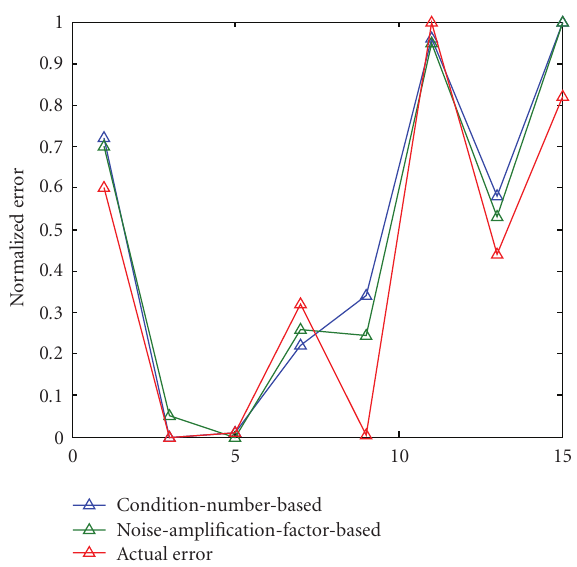
Figure 5: Normalized error predictions and actual error of two- dimensional